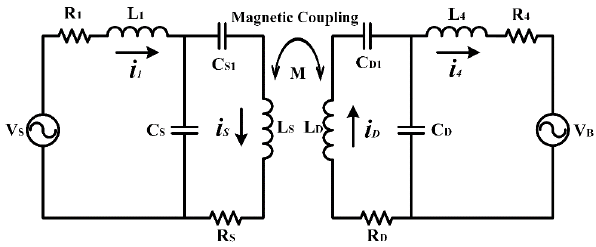
Figure 2. LCL ‐ LCL topology. Figure 2. LCL-LCL